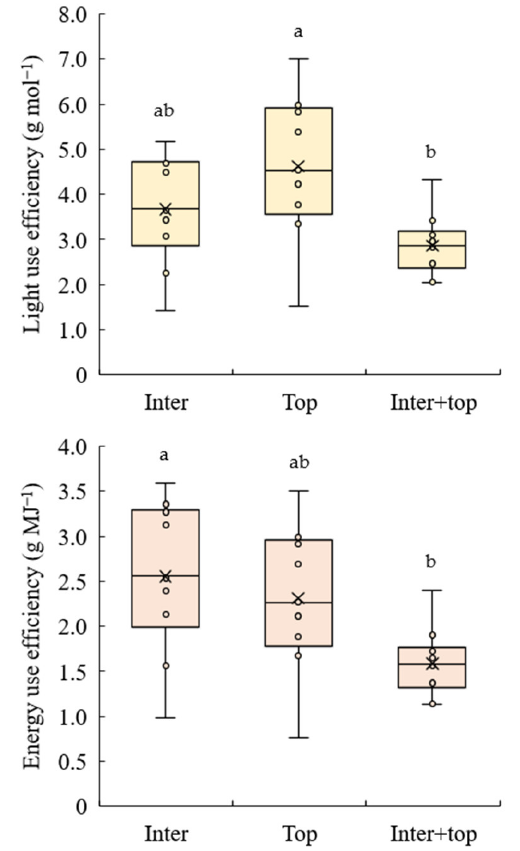
Figure 4. Light- and energy-use efficiency for tomatoes grown in a greenhouse under different LED SL treatments ( n = 10). Circles, crosses, and dash indicate values for each sample, means, and medians. Different letters indicate significant differences between treatments at p < 0.05 using the Tukey–Kramer